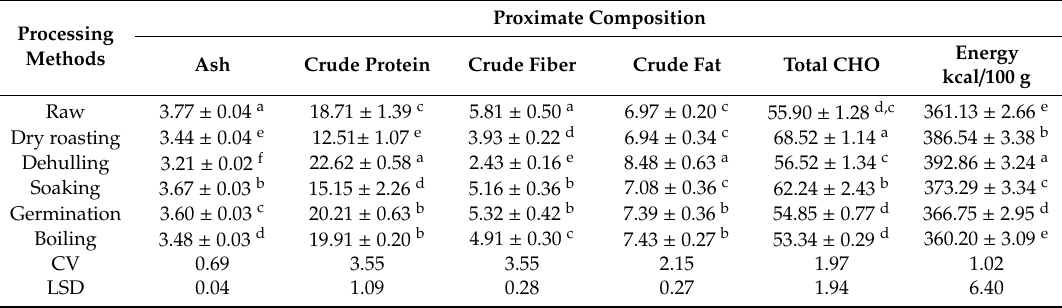
Table 1. E ff ect of processing methods on the proximate composition (% in db) and energy. Processing